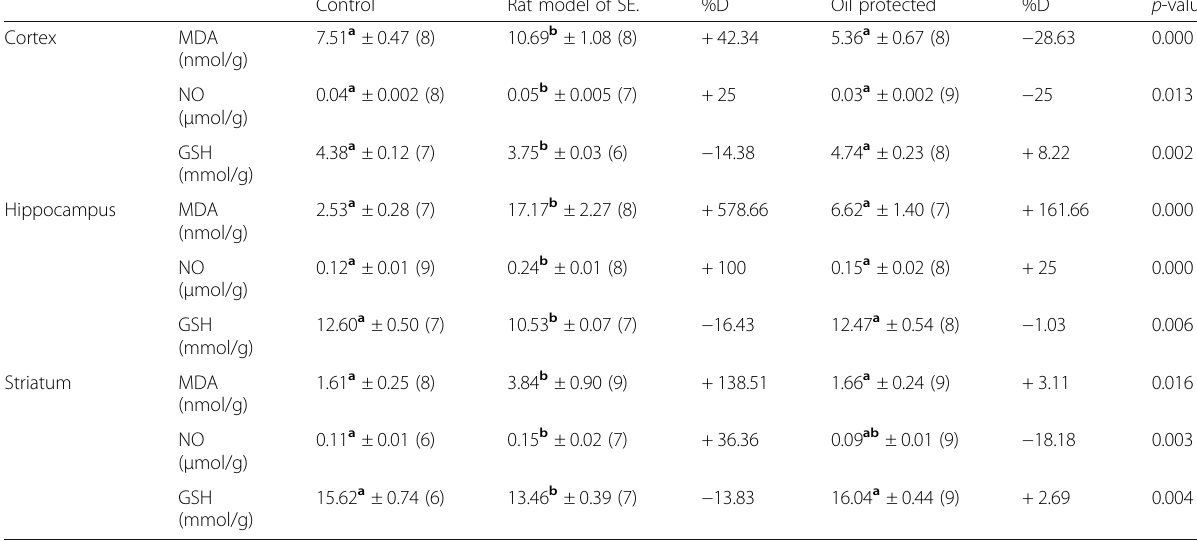
Values represent mean±S.E. with the number of animals between parentheses % D: % difference with respect to control values Different letters indicate significantly different means at p -value <0.05 Same letters indicate non significant